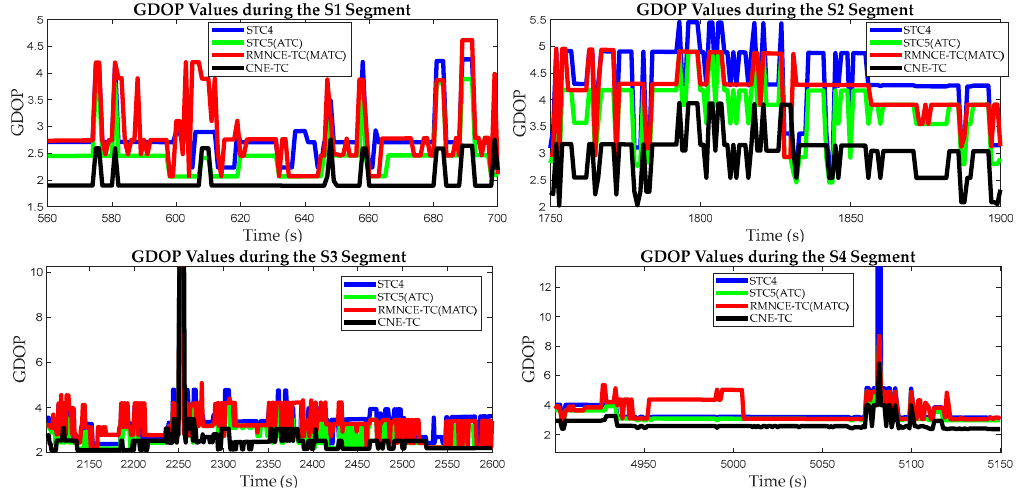
Figure 18. GDOP values of the different satellite selection algorithms during segments S1, S2, S3, and S4.